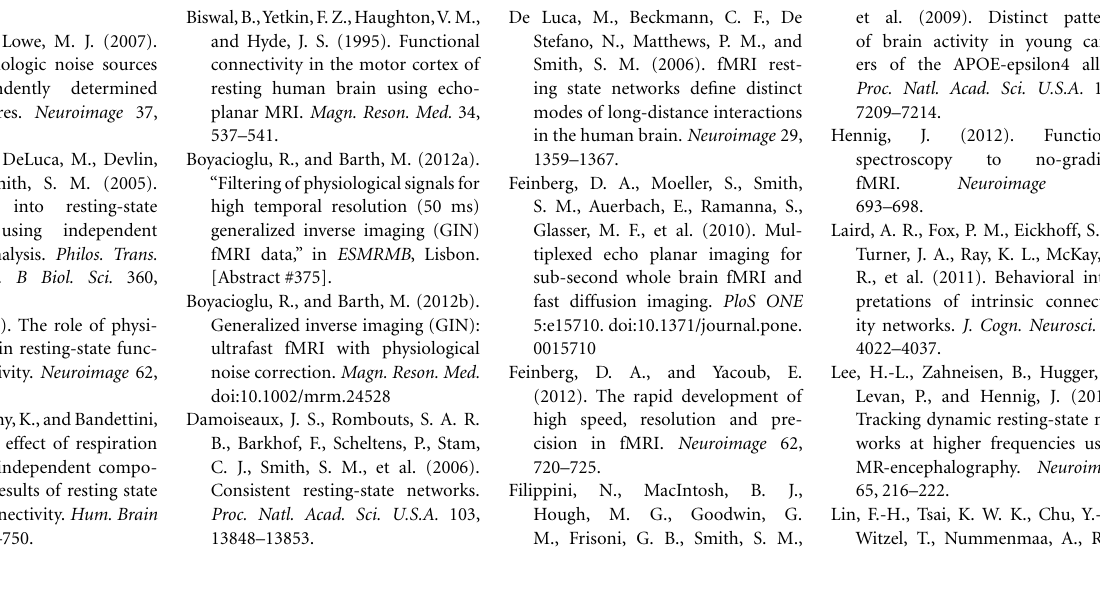
to separate the aliased voxels, this inevitably results in the trade off spatial resolution for increased temporal resolution. The effective resolution depends on the independent and uncoupled informa- tion available from the coil channels. In general, the effective resolution is higher for GM than white matter and poses fewer problems for fMRI. Naturally, the lower spatial resolution of GIN leads to a larger spatial extent especially in the left-right direction for some of the networks, leading to some of the relatively low DICE scores in Table 1 . Another drawback of low TR acquisitions